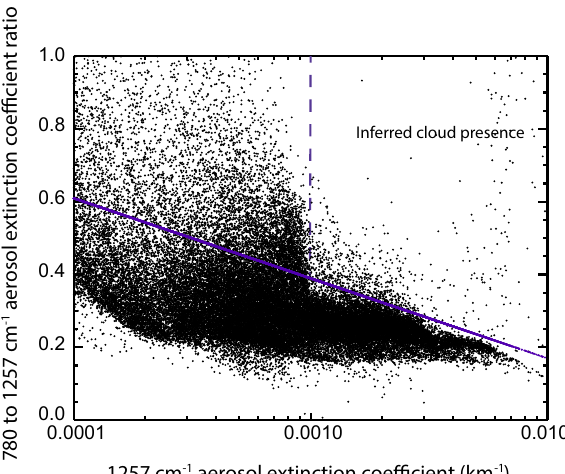
Figure 4. The distribution of CLAES 780 to 1257cm − 1 aerosol extinction coefficient measurements as a function of 1257cm − 1 aerosol extinction coefficient. Areas about and to the right of the blue lines almost exclusively occur in the lower stratosphere and appear to be associated with the presence of clouds. These points are excluded from further analysis.